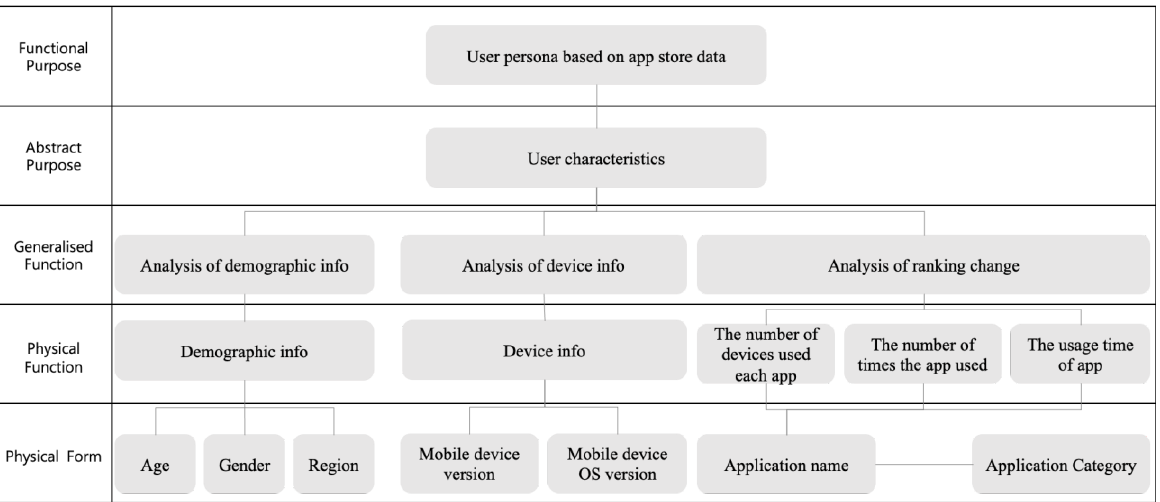
Figure 1. WDA of the new framework for creating personas based on the application store data.